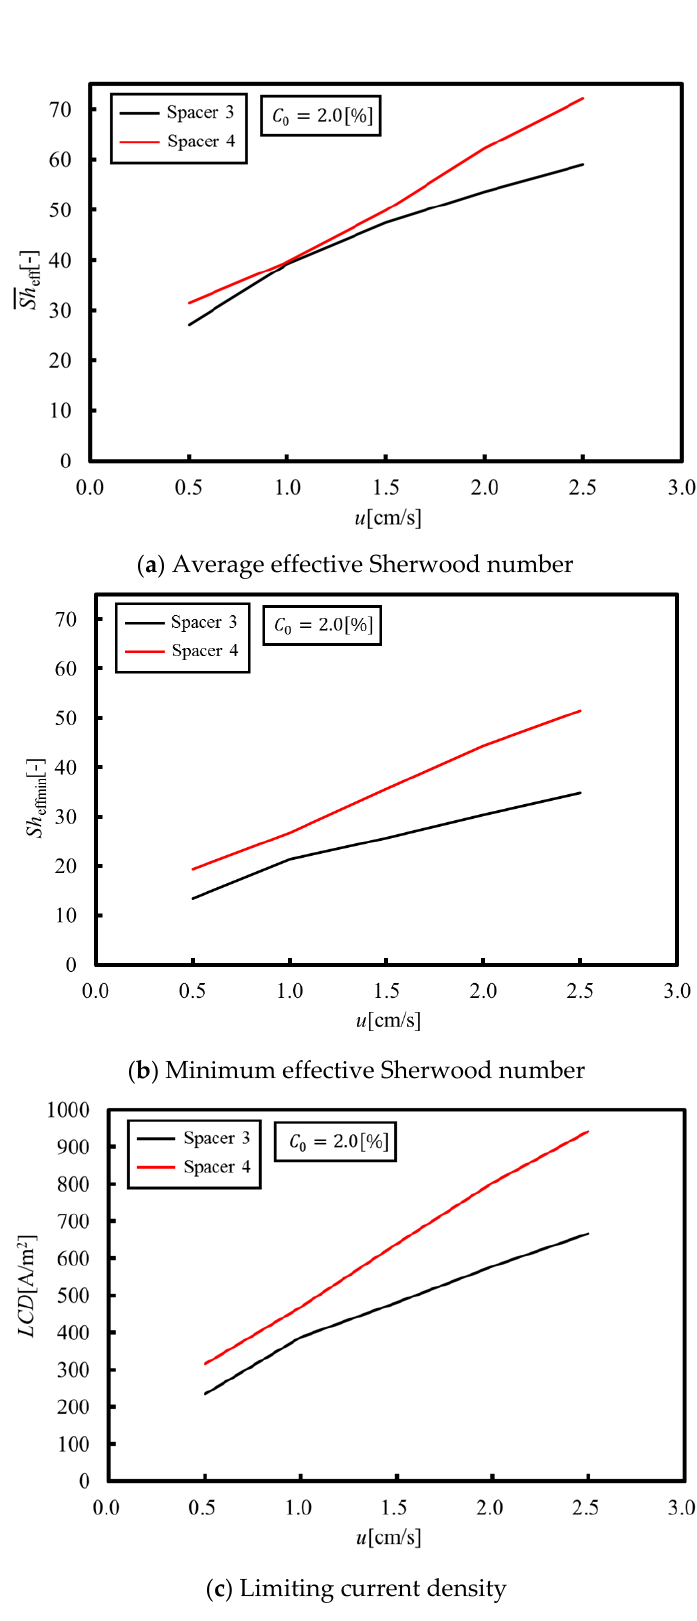
Figure 12. Effect of Spacer 4 on the average and minimum effective Sherwood numbers and on the limiting current density. ( a ) and ( b ) The average and minimum effective Sherwood numbers are greater than those of Spacer 3; ( c ) The LCD of Spacer 4 is also increased and is higher than that of Spacer 3, as a result of increasing the minimum effective Sherwood number.